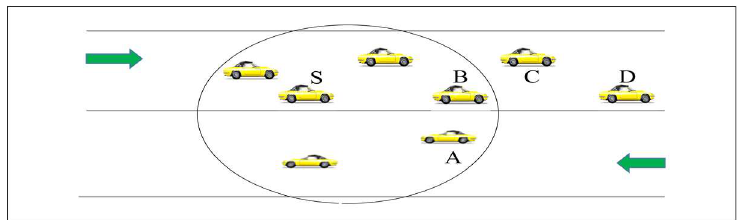
Figure 5. Working of greedy mode.